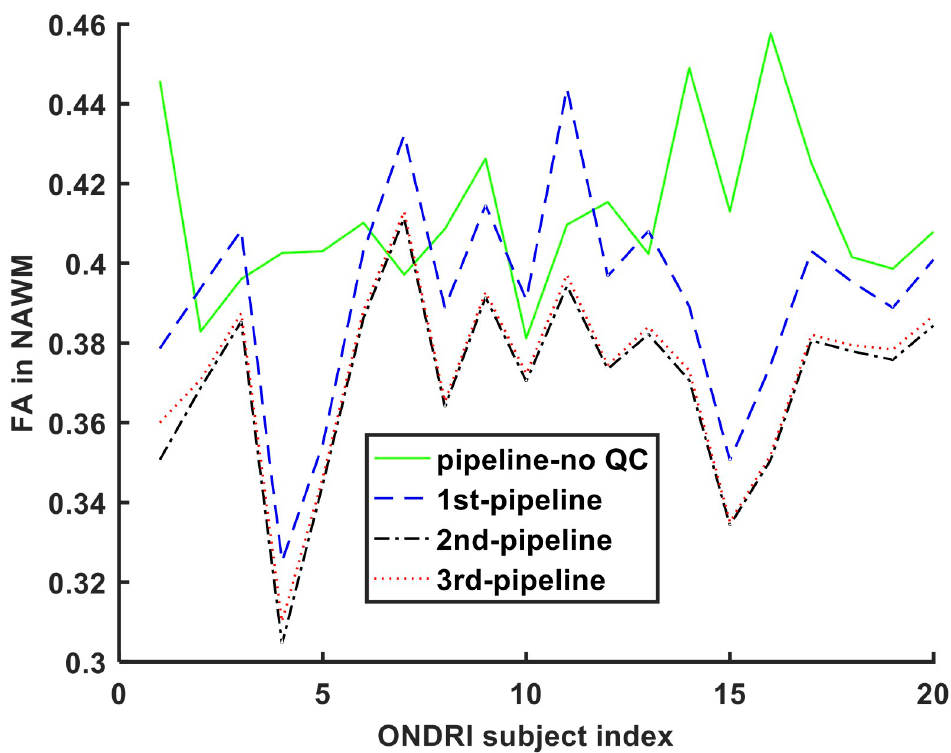
Fig 9. FA measurements in NAWM from 20 ONDRI VCI